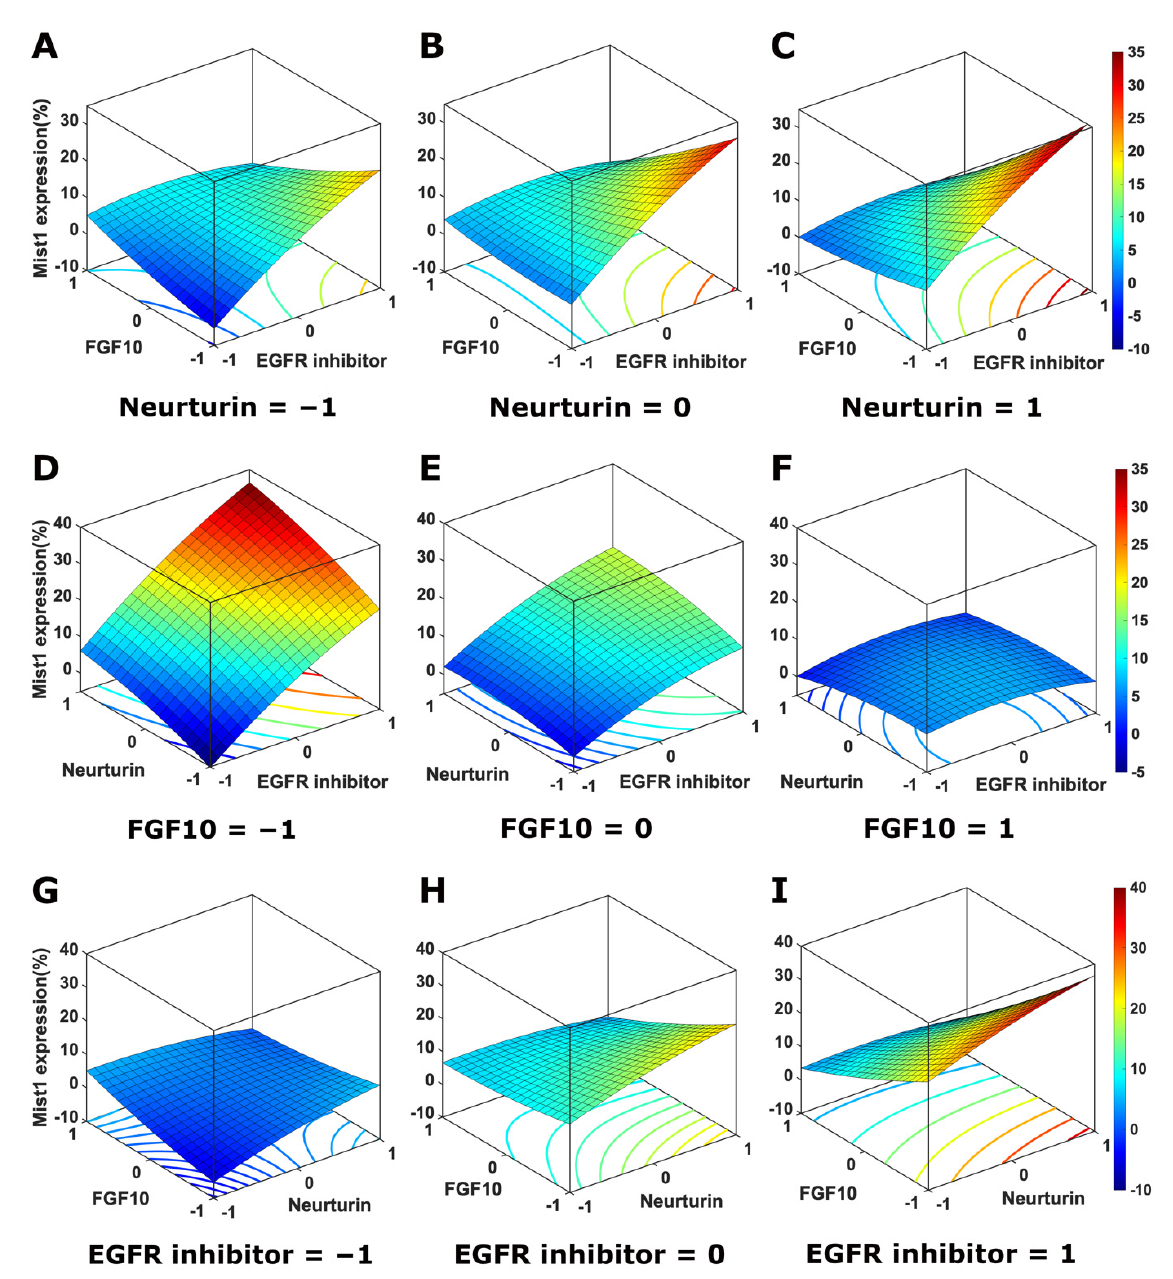
Figure 6. The EGFR inhibitor and FGF10 have opposing effects on Mist1 mRNA expression. 3D surface response and contour plots for the Box–Behnken DoE for Mist1 mRNA expression as a function of the concentration levels of EGFR inhibitor and FGF10 ( A – C ) with neurturin fixed at level − 1 ( A ), 0 ( B ), and 1 ( C ); EGFR inhibitor and neurturin ( D – F ) with FGF10 at level − 1 ( D ), 0 ( E ), and 1 ( F ); and neurturin and FGF10 ( G – I ) with the EGFR inhibitor at level − 1 ( G ), 0 ( H ), and 1 ( I ). Concentrations levels correspond to values in Table 1.